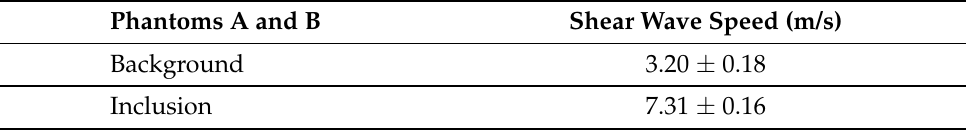
Table 2. Values for the shear wave speed (mean ± sd) for the background and the inclusion in both